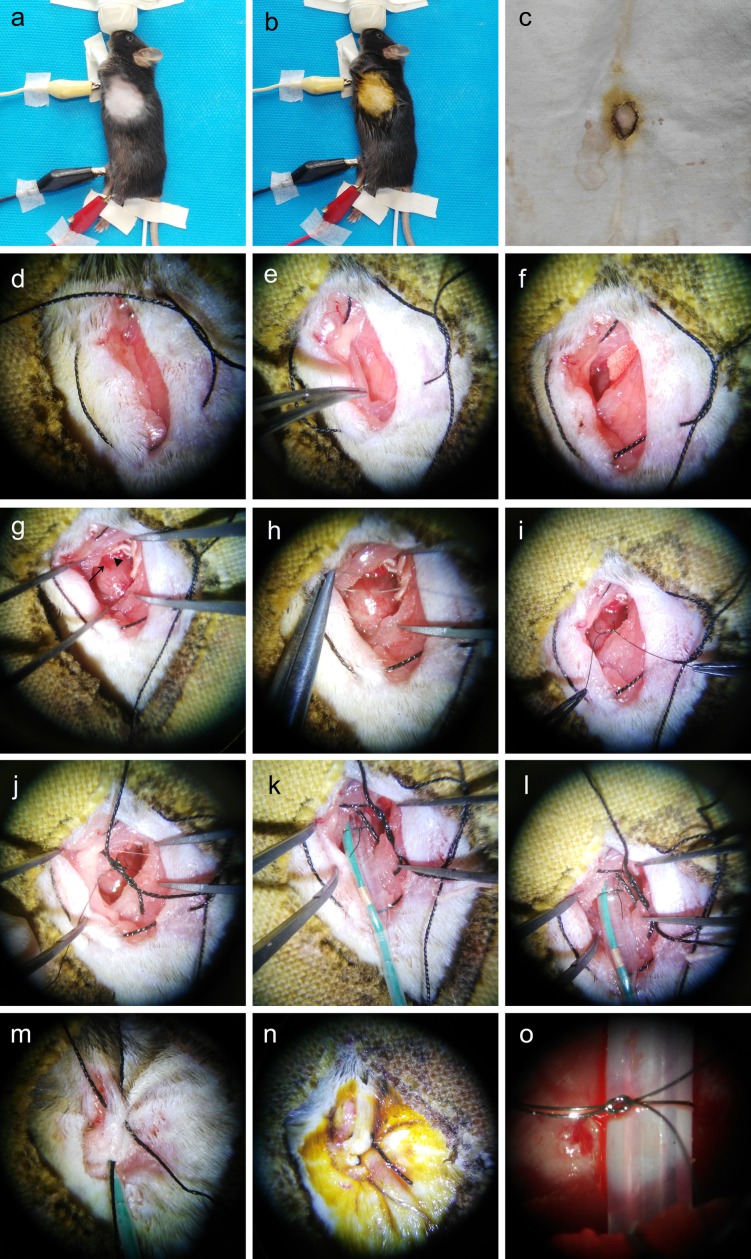
Photographs of various stages of the new method.a, b. The mouse was located on its right side and connected with ventilation and a Data Analysis System. The skin was depilated and disinfected. c. The skin was covered with aseptic hole-towel. d. A 1 cm skin incision and a purse suture were made. e. The pectoralis muscles were separated and the intercostal muscles were exhibited. f. A small hole was made at the fourth intercostal muscle. g. A small wet sterile gauze was used to protect the lungs. The LAD (↑) and left auricle (◀) were displayed. h. One hand held the microneedle holder with a surgical suture needle to pass underneath the LAD and another hand held a smooth tying forceps to widen the hole. i. An approximate 2-mm diameter loop was made. j. A 4–0 suture was passed through the third and fifth intercostal muscle. k. A deflated balloon was placed in the loop. l. The balloon was inflated. m. The chest cavity was closed by straining the purse suture. n. The wound was closed. o. In the classic method, a PE-10 tube was used and a slipknot was made.